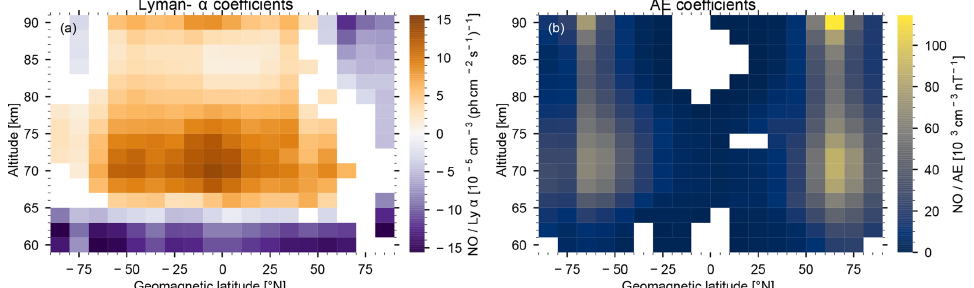
Figure 3. Latitude–altitude distributions of the fitted solar index parameter (Lyman- α , a ) and the geomagnetic index parameter (AE, b ) from the non-linear model.